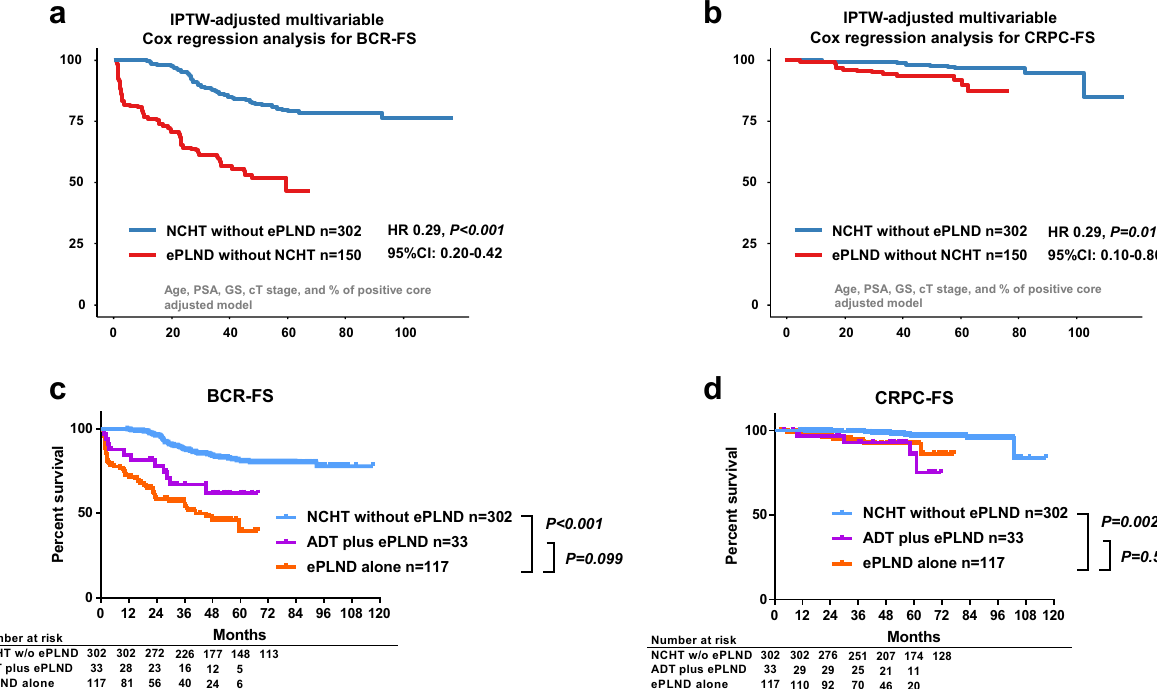
Figure 2. Comparison of oncological outcomes between ePLND during RARP and NCHT plus RARP without ePLND. ( a ) The Cox regression analysis using inverse probability weighting (IPTW) methods of biochemical recurrence-free survival (BCR-FS). ( b ) The Cox regression analysis using IPTW methods of castration-resistant prostate cancer-free survival (CRPC-FS). ( c ) Unadjusted analysis of biochemical recurrence-free survival (BCR-FS). ( d ) Unadjusted analysis of castration-resistant prostate cancer-free survival (CRPC-FS). ePLND extended pelvic lymph-node dissection, GS Gleason score, NCHT neoadjuvant chemohormonal therapy, PSA prostate-specific antigen, RARP robot-assisted radical